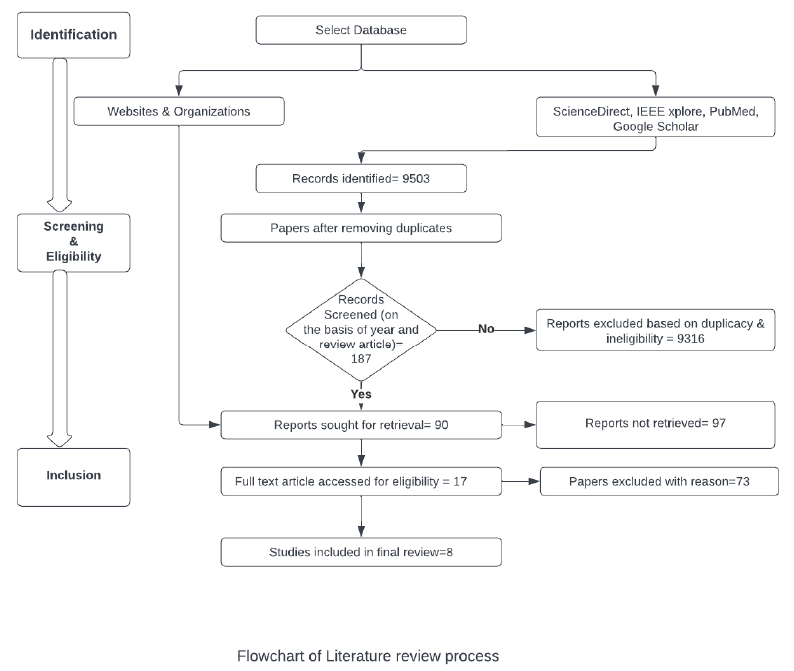
Figure 6. Figure 6. PRISMA.